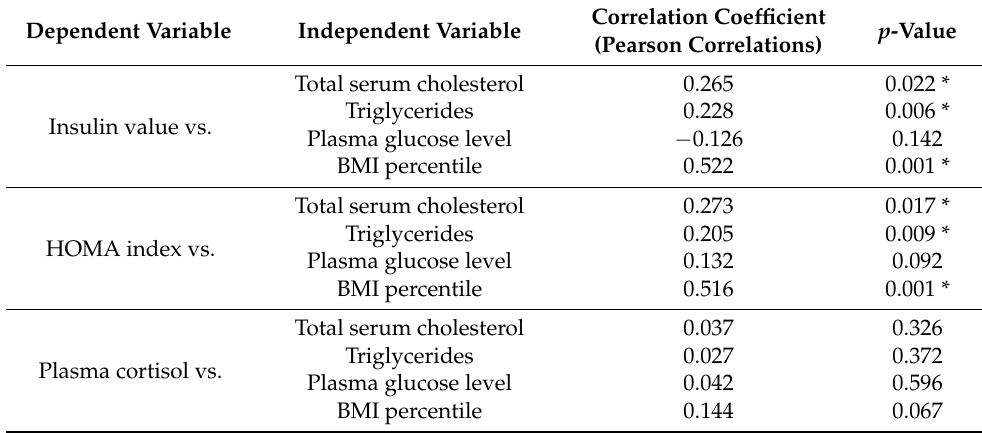
Table 4. Univariate analysis showing correlations between metabolic markers of insulin resistance and biochemical parameters and BMI